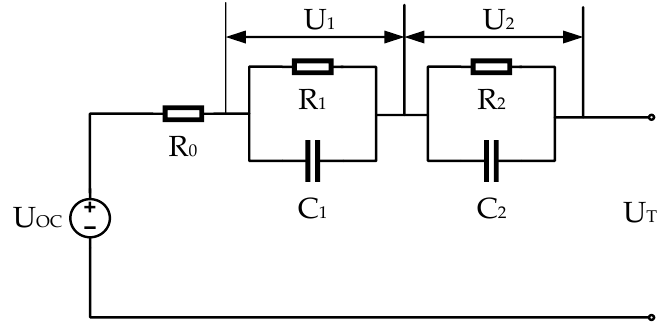
Figure 2. Model structure of 2-RC equivalent circuit.